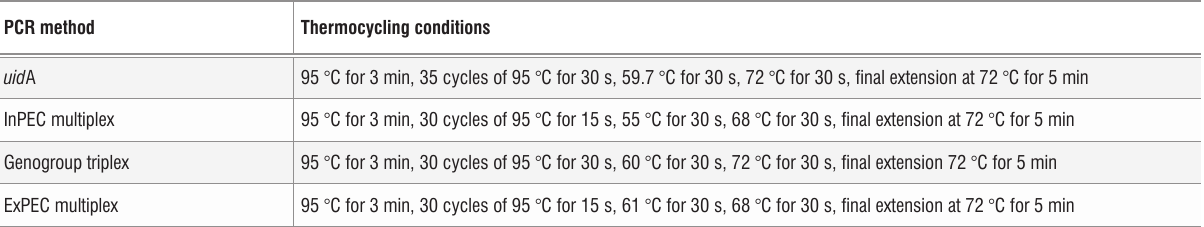
Table 2: Thermocycling conditions used for uid A, triplex, InPEC and ExPEC polymerase chain reactions (PCRs) PCR method Thermocycling